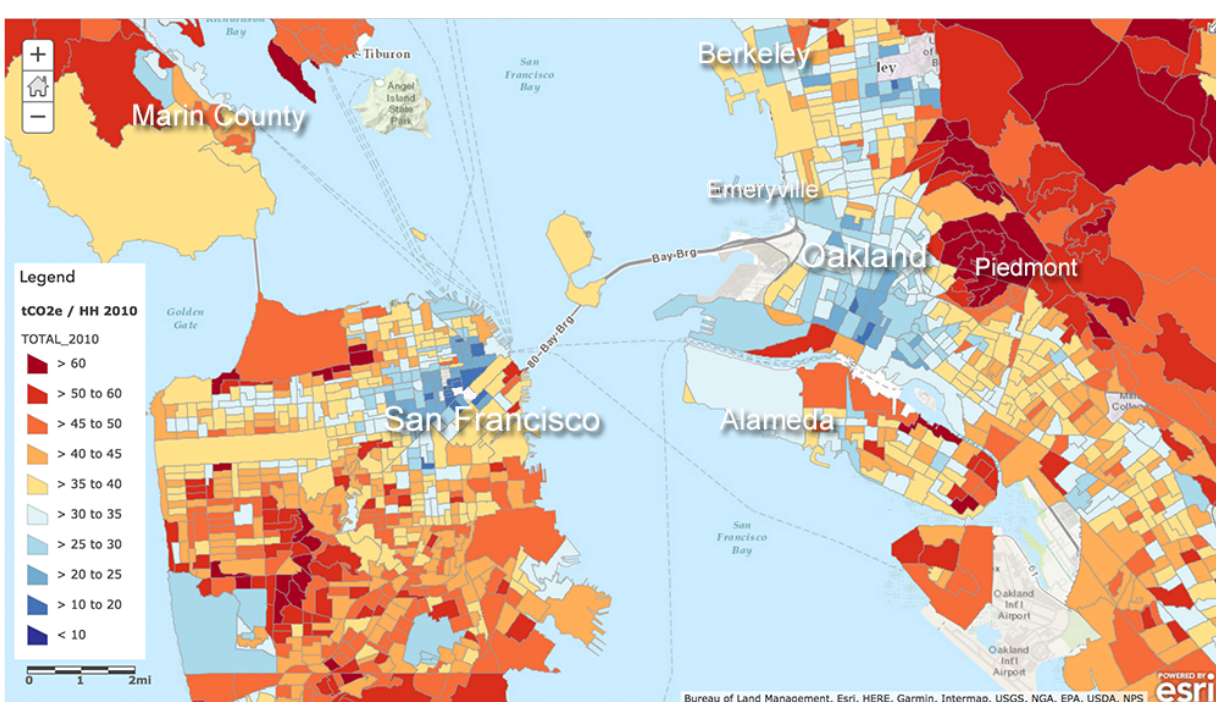
Figure 2. Carbon footprint of S.F. Bay Area households by Census block group.